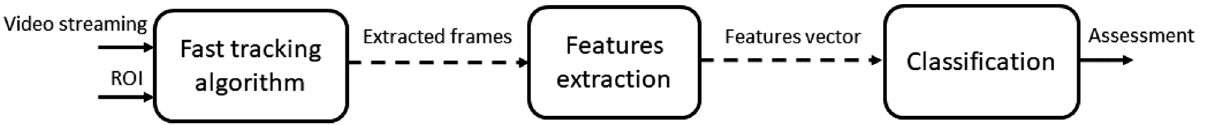
Figure 1. Block architecture of the proposed algorithm. Three main blocks are outlined: (i) a fast tracking algorithm to track the selected ROI, (ii) a feature extraction block to pre-process the available frames and (iii) a ML-based classifier to provide the output in terms of quality of